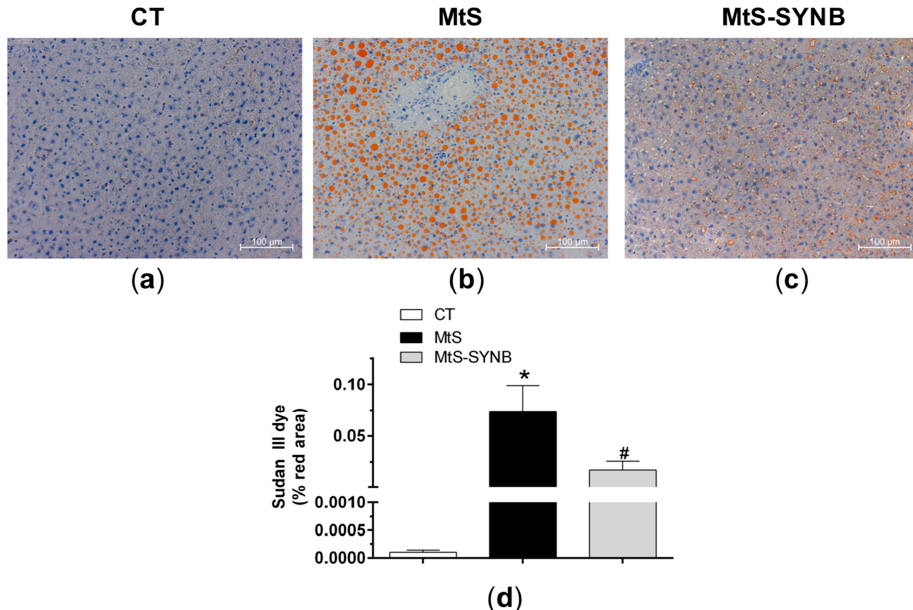
Figure 3. Liver sections were stained with Sudan III lipid dye. Representative images (20 × magnification) from CT ( a ), MtS ( b ) and MtS-SYNB ( c ) rats are shown. The scale bar represents